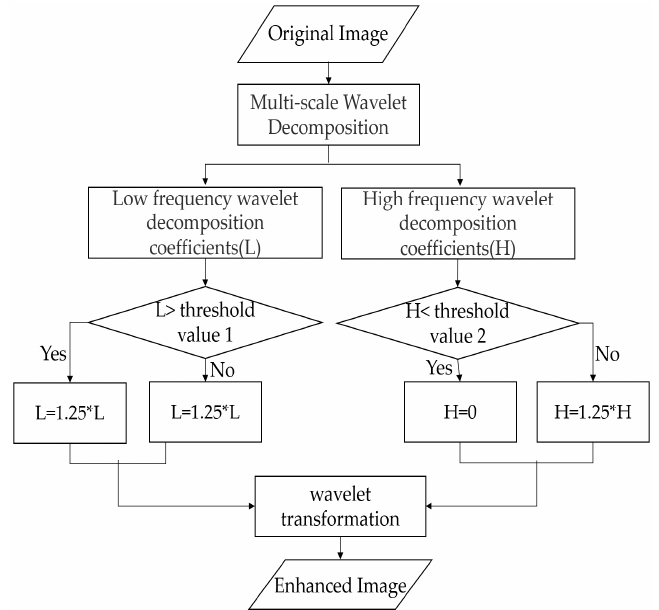
Figure 7. The processes of the wavelet transform.